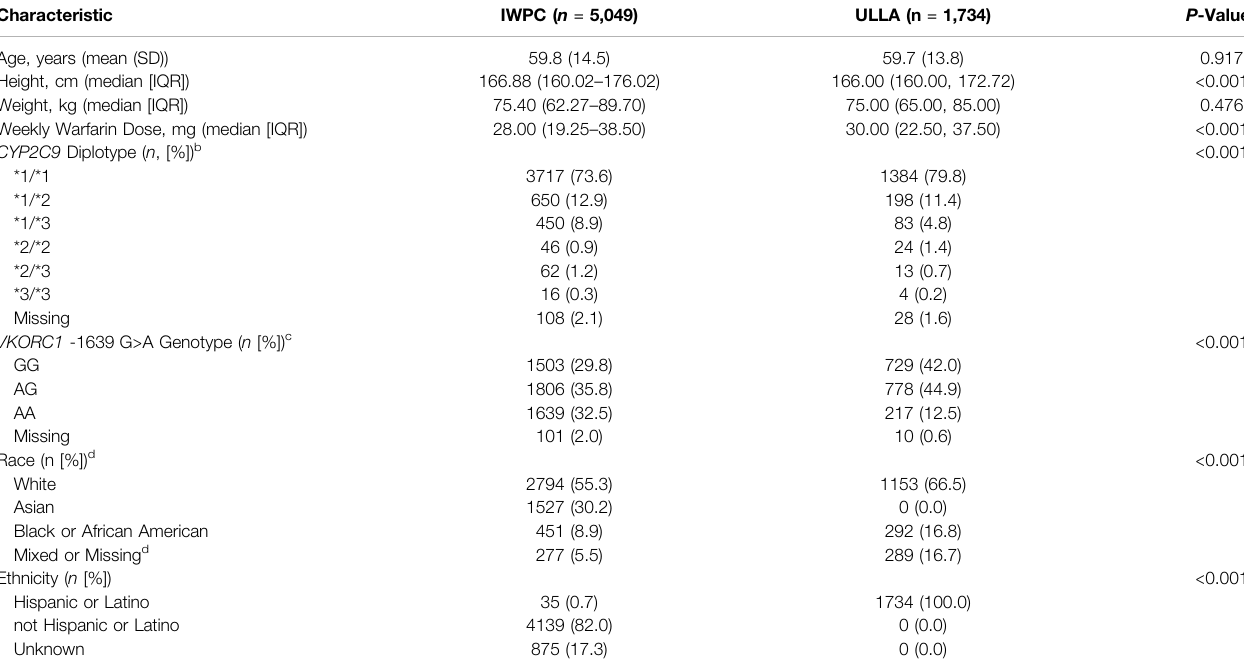
TABLE 1 | Subject Characteristics in IWPC and ULLA cohorts.